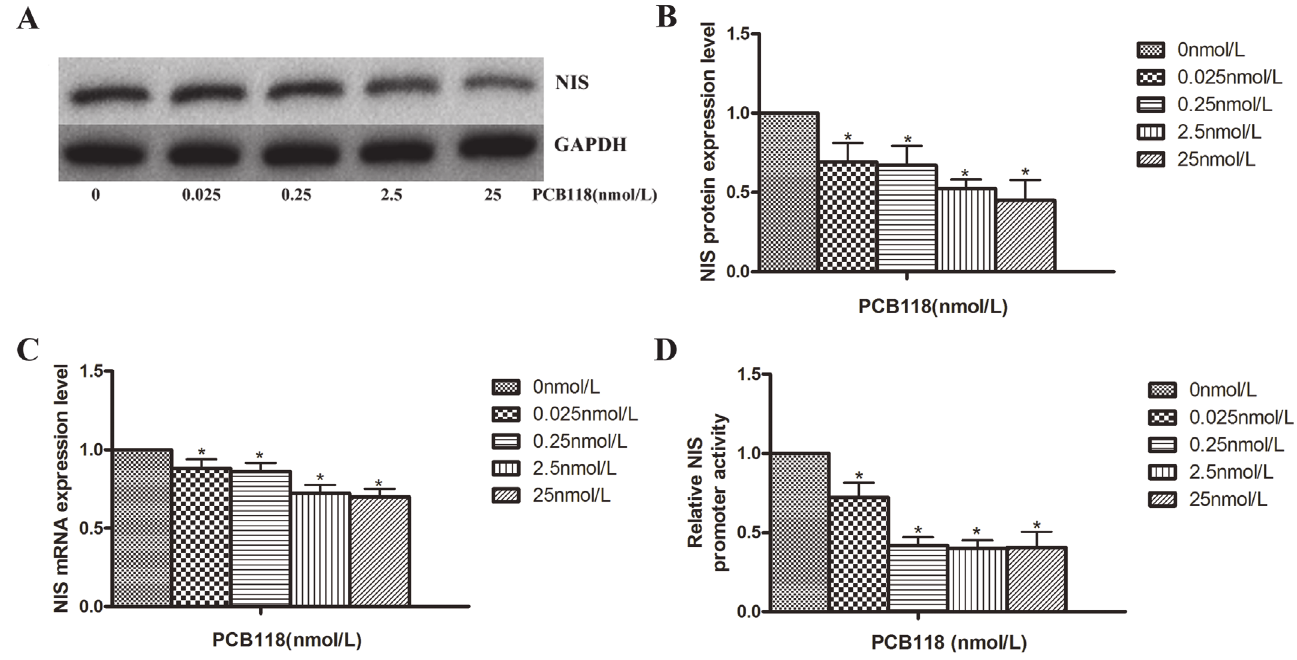
Fig 3. Exposure of FRTL-5 cells to PCB118 results in the down-regulation of NIS expression. Cells were treated with DMSO or various concentrations of PCB118 (0.025 – 25 nM) for 24 or 48 h. Whole cell lysates were analyzed by western blotting using antibodies recognizing NIS (A and B). Total RNA was isolated for qRT-PCR of NIS (C), and the FRTL-5 cells were harvested for the measurement of NIS promoter activity (D). Results show sections of blots from one experiment of the three that yielded similar results (A) or represented the mean ± SD of three independent experiments (B, C, and D). GAPDH served as the loading control in western blotting. * p < 0.05, compared with the DMSO control group. The relative ratio of target mRNA/ β -actin, target protein/GAPDH and promoter activity in solvent control group was set as 1.